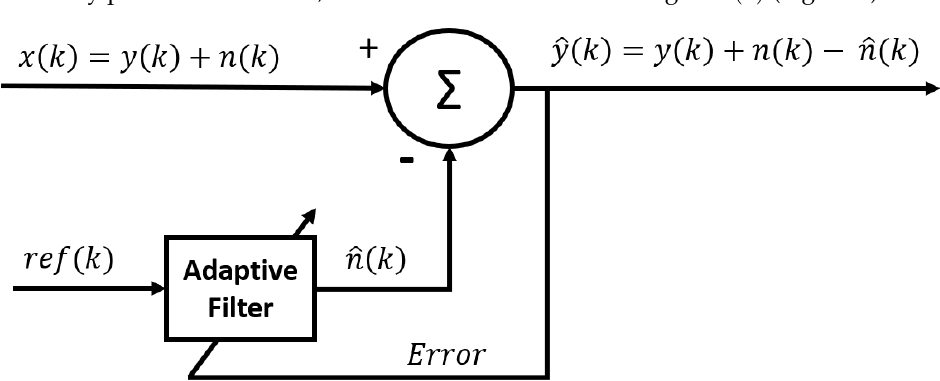
Figure 5. Block diagram of the classic adaptive noise